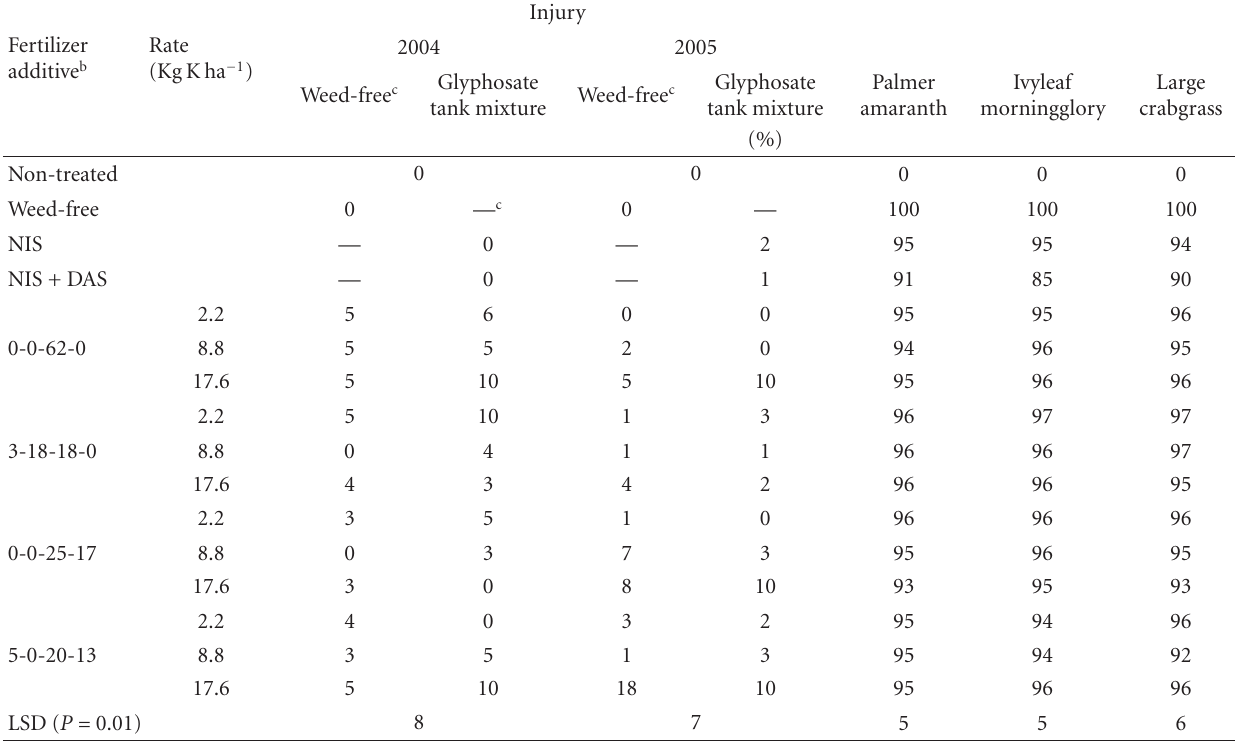
Table 4: Soybean injury and weed control from fertilizer additives applied alone in a weed-free plot and tank-mixed with glyphosate plus non-ionic surfactant 14 days after treatment (DAT) at Portageville in 2004 and 2005 in weedy plots. Palmer amaranth, ivyleaf morning glory, and large crabgrass control of fertilizer additives plus glyphosate and nonionic surfactant 21 DAT at Portageville a . Data were combined over